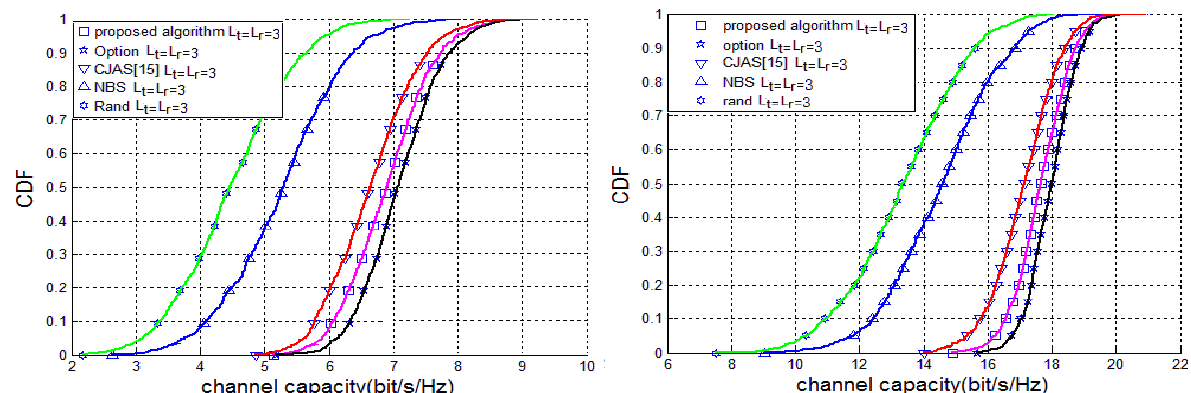
Fig. 10 the curves of capacity CDF for { 7 , 3;7 , 3 } system, SNR=8dB